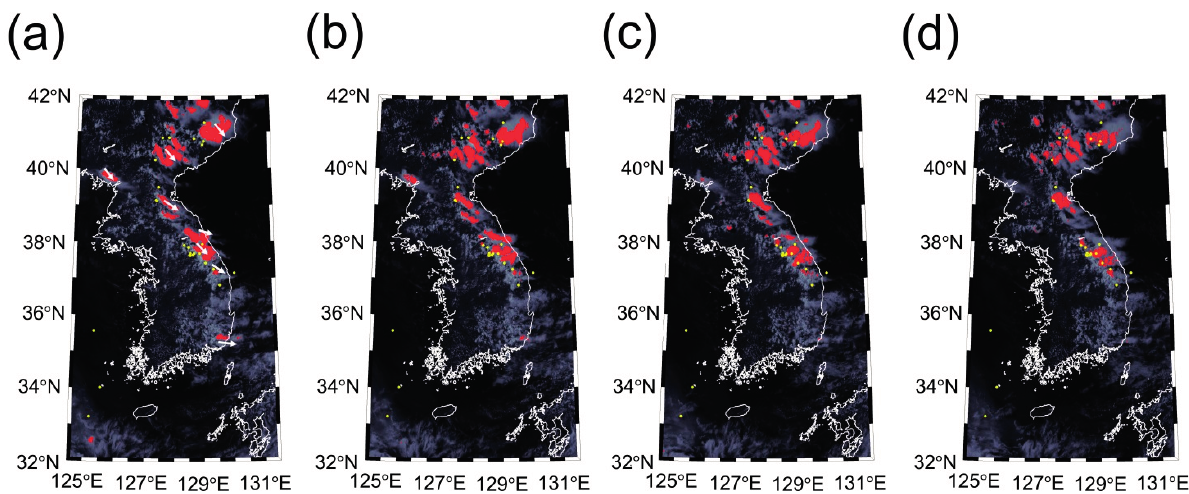
Figure 8. CI detection maps for the case in 2014 (CI by unstable atmosphere) generated from the RF model, overlaid with COMS MI IR1 images obtained ( a ) 60 min, ( b ) 45 min, ( c ) 30 min, and ( d ) 15 min before the image acquisition at the nearest time of the lightning occurrence. Red objects are the predicted CI and yellow dots represent the location of lightning occurrences. White arrows in (a) represent the movement directions of cloud